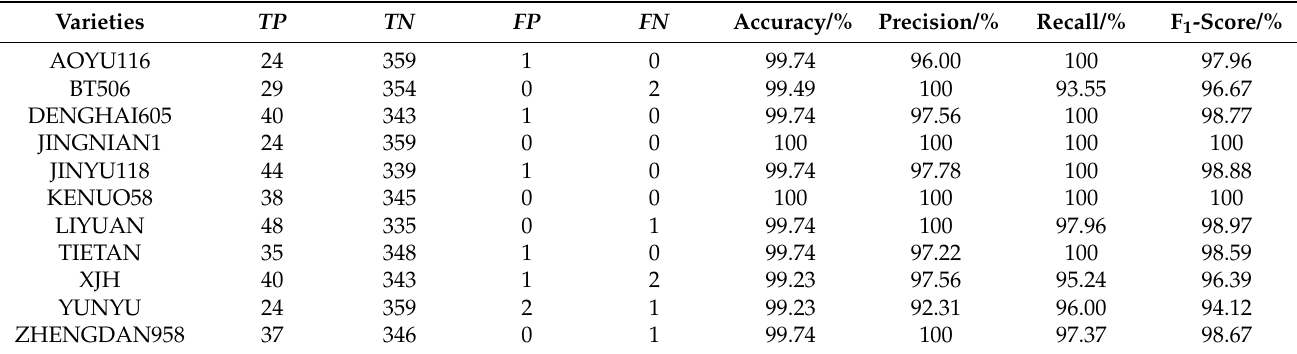
Table 4. I_CBAM_MobileNetV2 quantitative evaluation results.